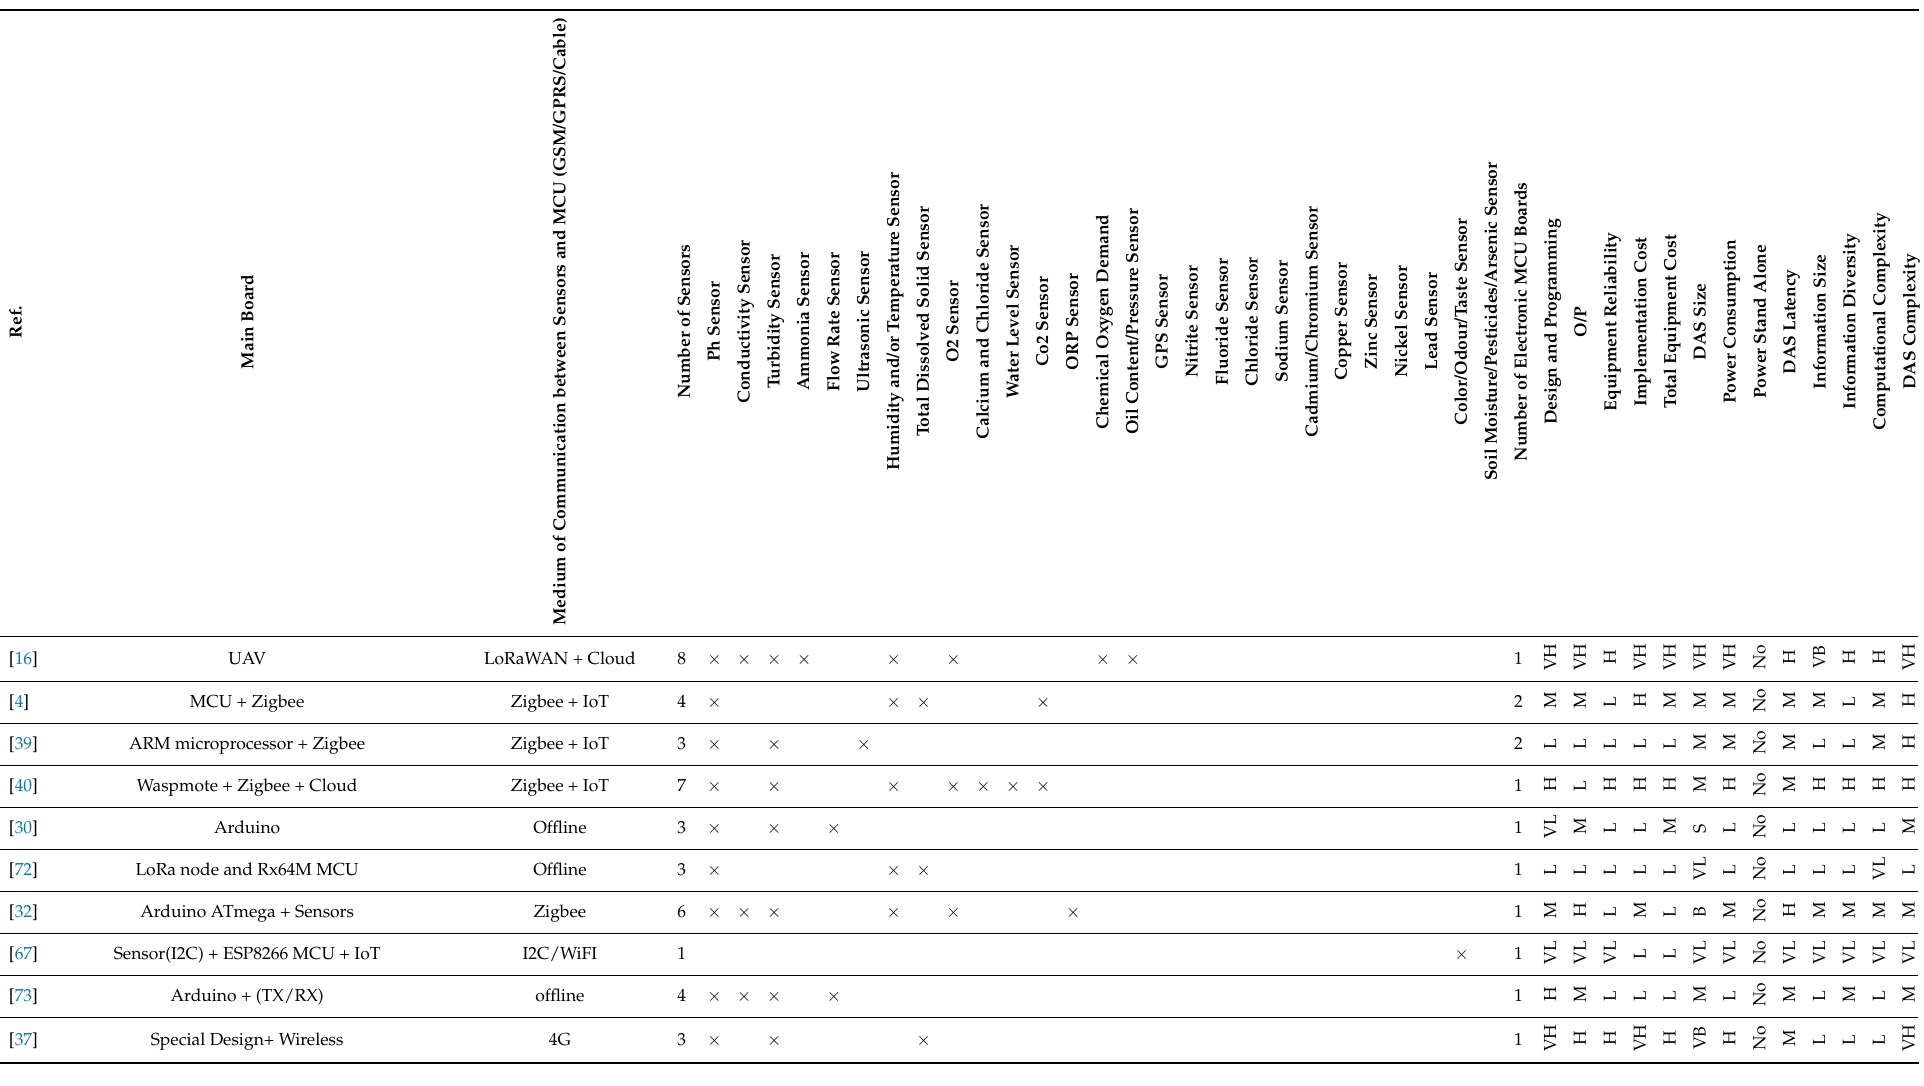
Table 1. Technology Analysis of Water Quality